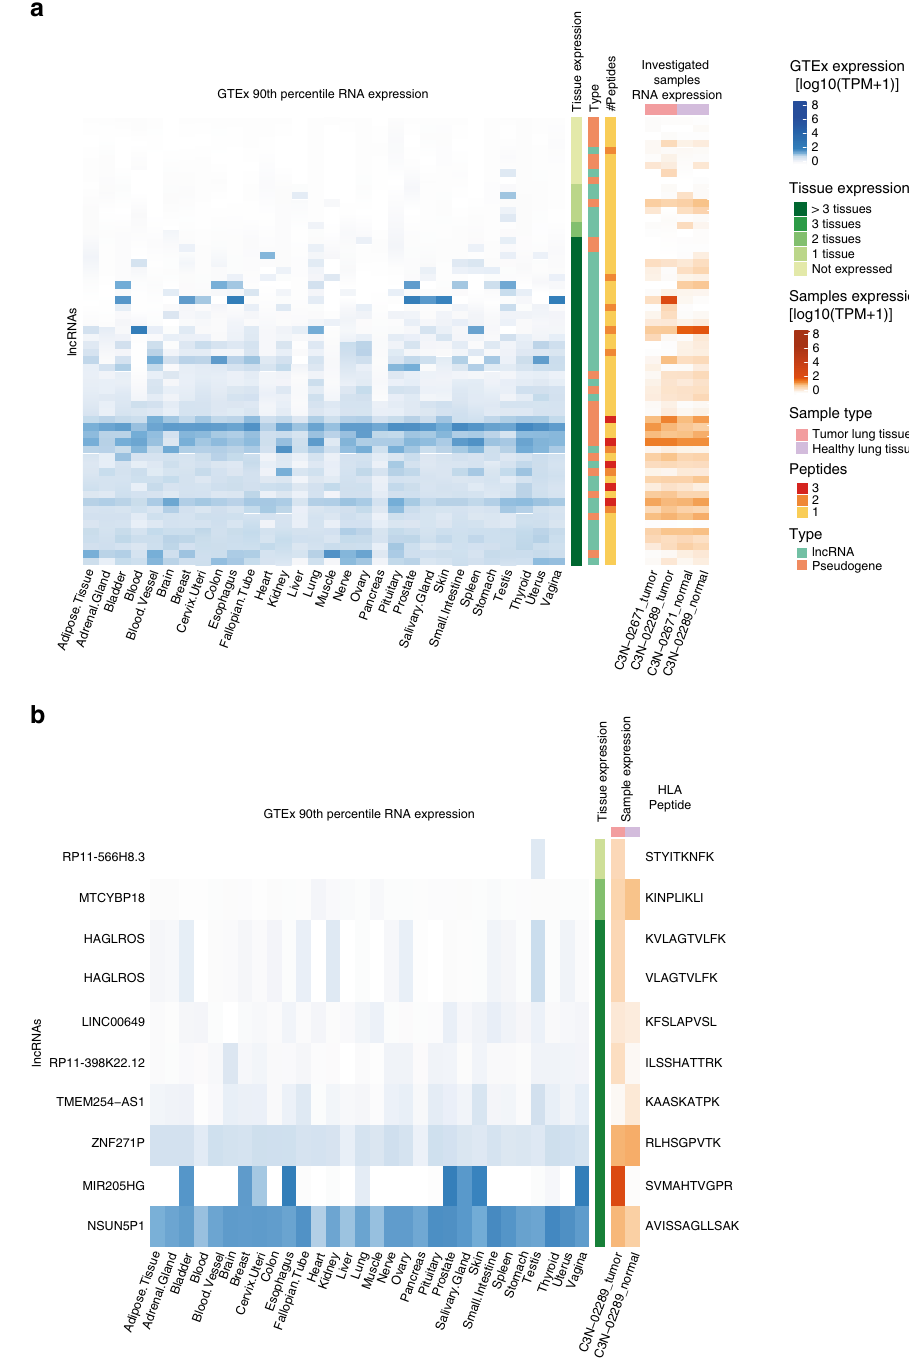
Fig. 7 Non-coding source gene expression from lung cancer patient samples in healthy tissues. A comparison of presumed non-coding source gene expression in the investigated samples to that in healthy tissues (GTEx). a Heatmap of lncRNA source genes showing the 90th percentile gene expression levels across 30 healthy tissues on the left and the gene expression levels identi fi ed in lung tissue samples on the right. Tissue gene expression was classi fi ed as not expressed (90th percentile TPM ≤ 1) in any, 1 – 3, or >3 tissues other than testis to assess tumor speci fi city. The number of HLAIp identi fi ed per gene is depicted as well as the gene (GENCODE) and sample type. b Speci fi cally, this was also plotted for the tumor-speci fi c noncHLAIp identi fi ed in lung cancer patient C3N-02289. Source data are provided as a Source Data fi